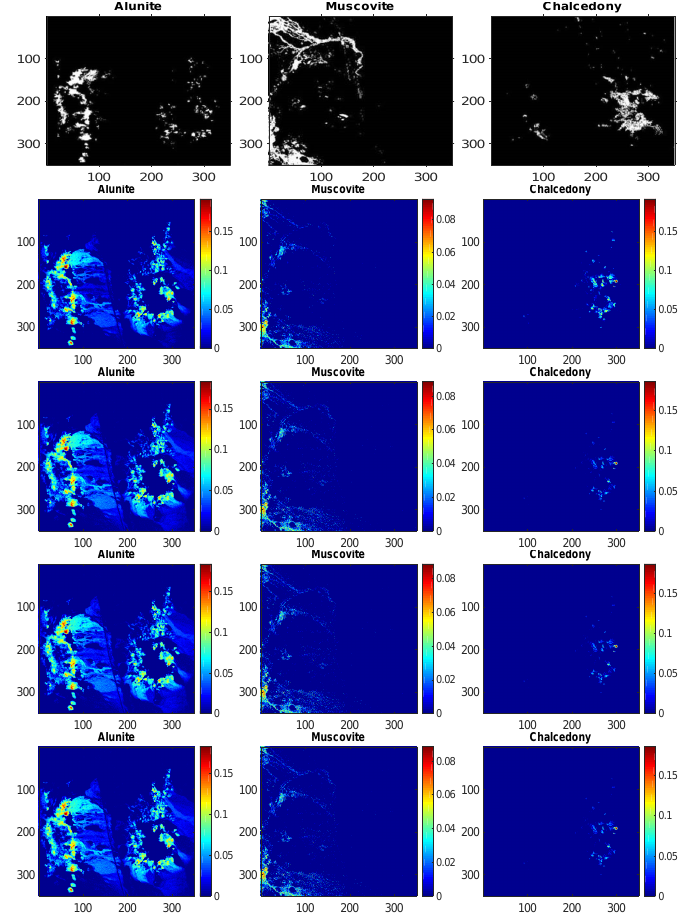
Figure 6. Fractional abundance maps estimated for the AVIRIS Cuprite subscene with the USGS library. From top to bottom: Software product, the estimated fractional abundance maps by DRSU-TV, GraphHU, SGHU and